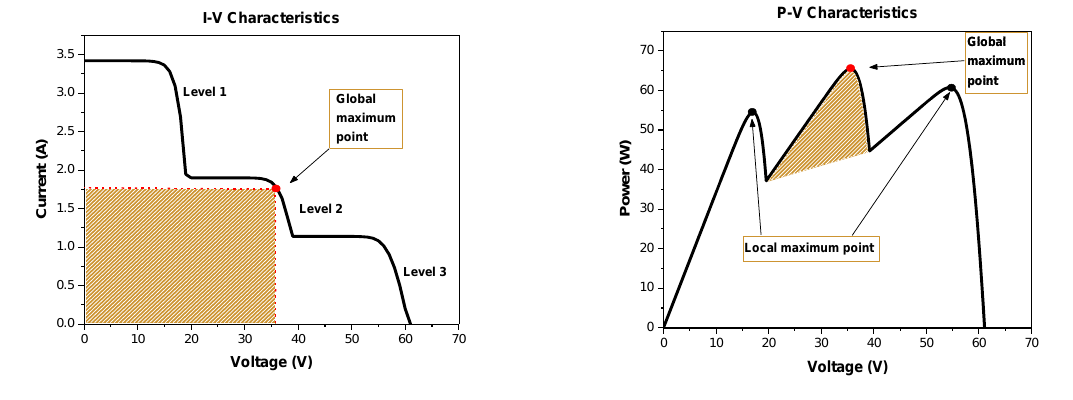
Figure 7. Series-connection of PV modules.